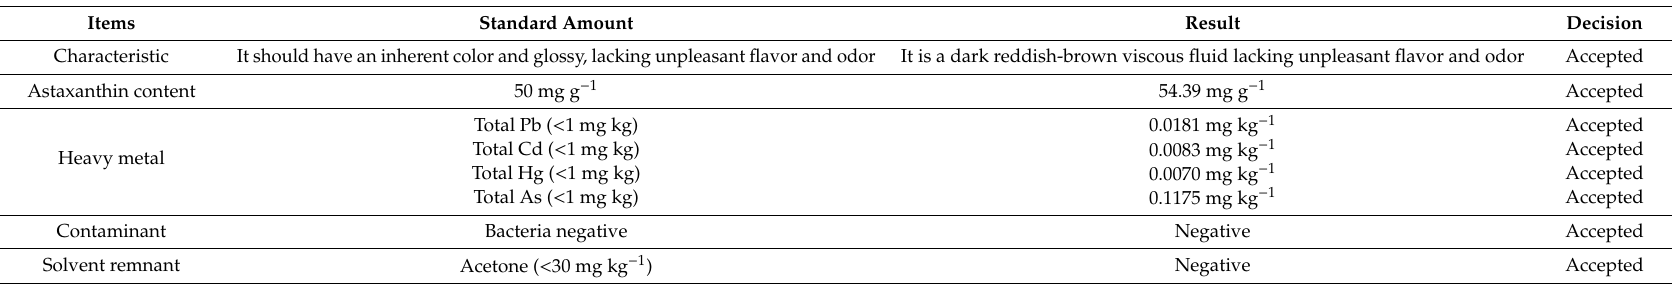
Table 2. Korea Food and Drug Administration (KFDA) approval and compliance testing for the H. pluvialis extracts derived from the LNG-fired flue gas.